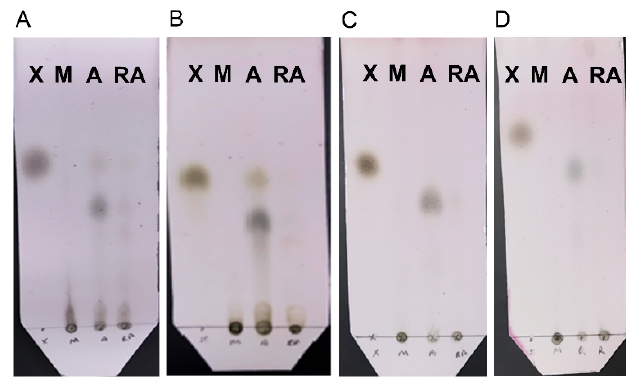
Figure 6. Thin Layer Chromatography (TLC) analysis of the soluble products of enzymatic reactions after 30 min milling (M), 30 min milling and 72 h aging at 55 °C (A), or 12 h RAging via 12 cycles of 5 min milling followed by 55 min aging (RA), starting from either 200 mg of birchwood (Panel A ) or oat spelt (Panel B ) xylans hydrolyzed using 0.13% w / w protein loading at η = 1 µ L / mg, or 400 mg of sugarcane bagasse (Panel C ) or wheat straw (Panel D ) biomass hydrolyzed with 0.08% w / w protein at η = 0.6 µ L / mg. Lane X was loaded with the monosaccharide standard xylose.